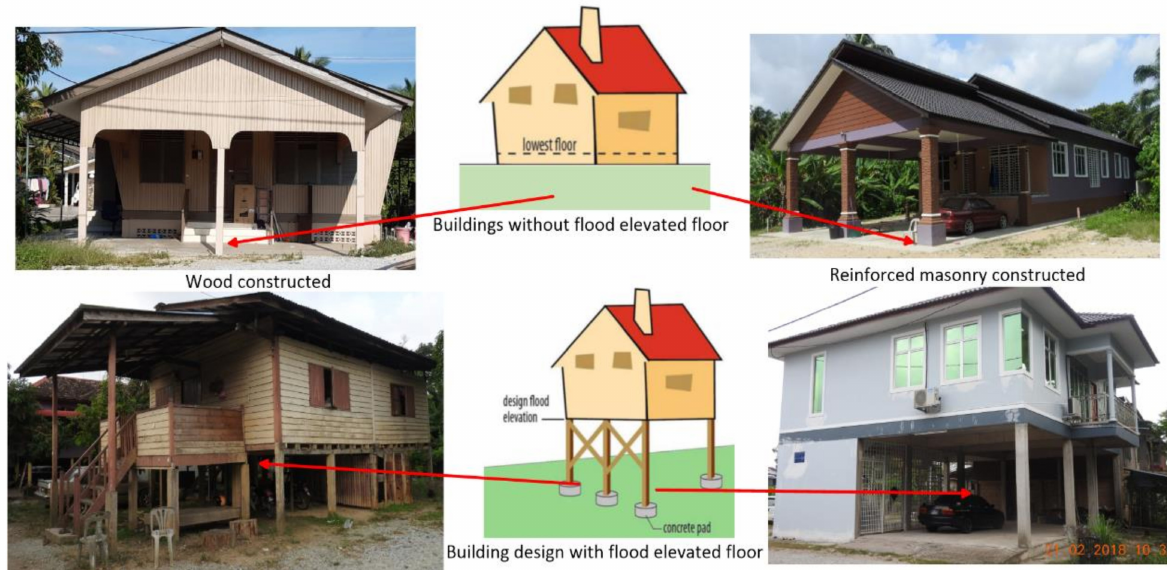
Figure 13. An illustration of elevated and non-elevated